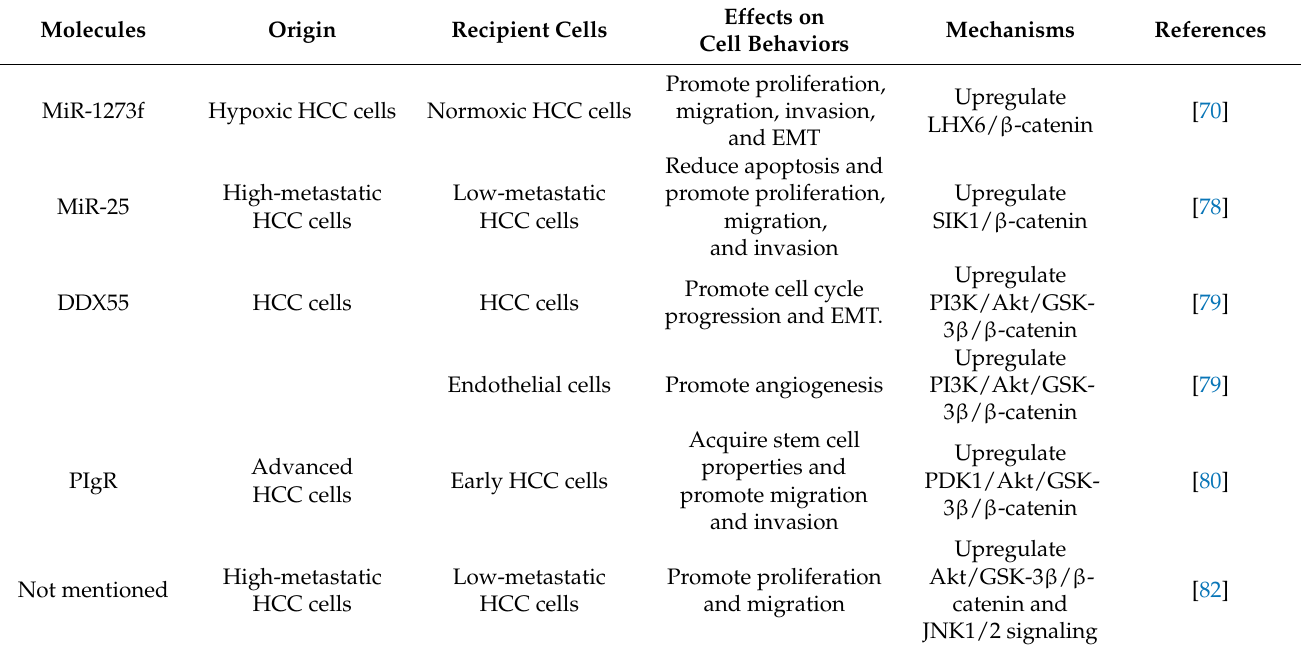
Table 1. EVs derived from HCC